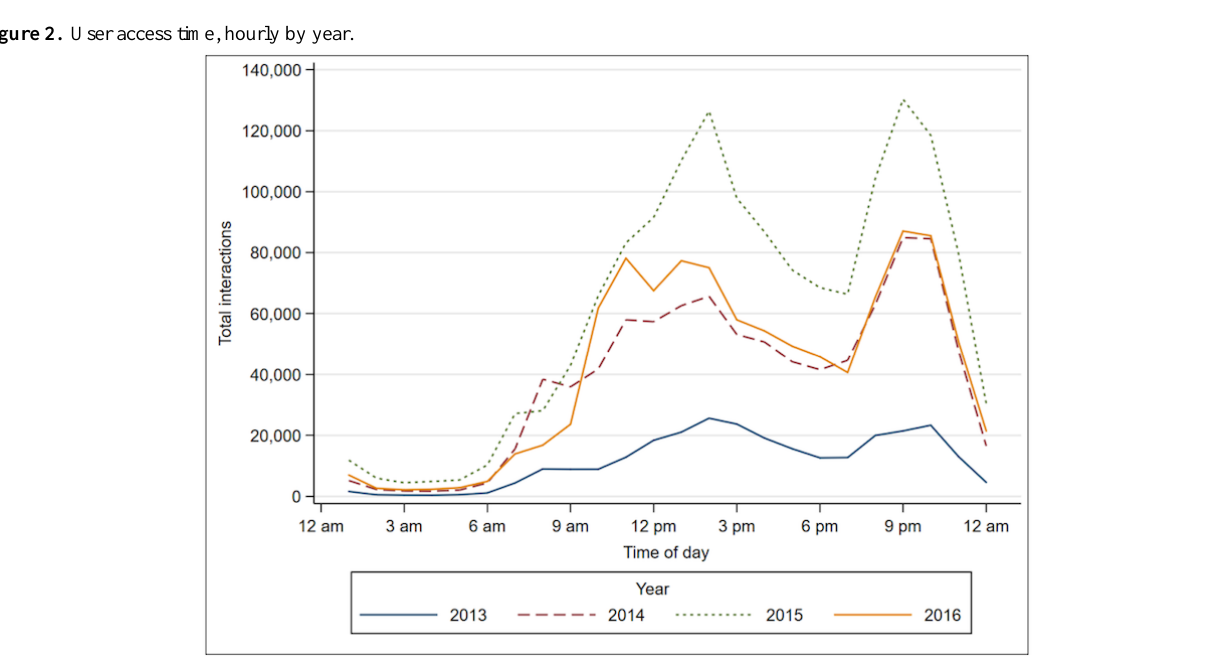
Figure 2. User access time, hourly by